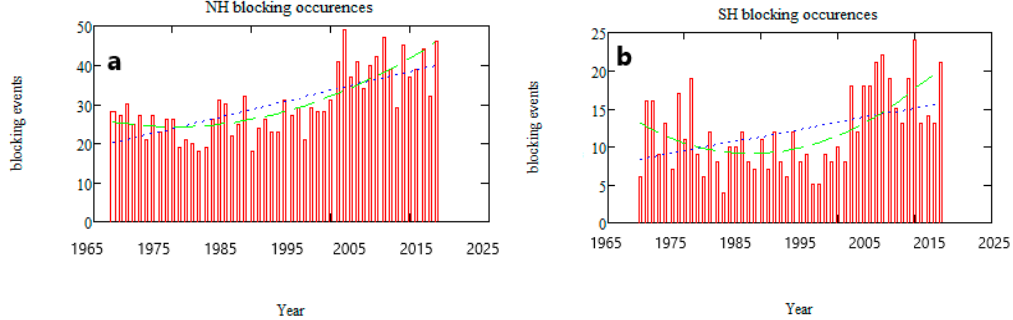
Figure 3. The occurrence of blocking for ( a ) the NH, and ( b ) the SH with time. The blue dashed line is a linear trend line, while the green dashed line is a quadratic fit.